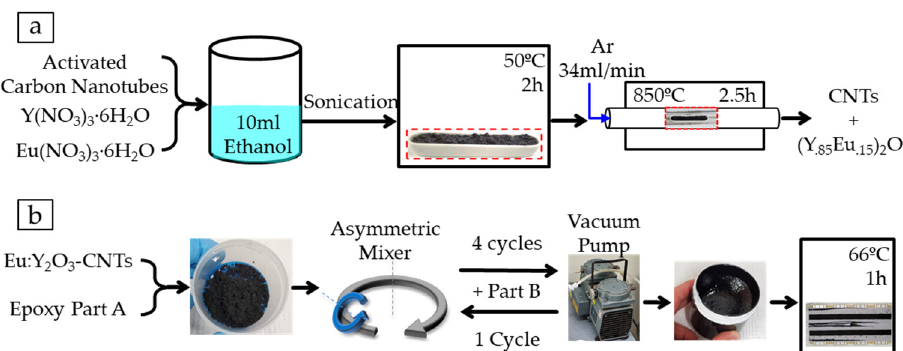
Figure 1. Depiction of the processes for: ( a ) introducing Eu:Y 2 O 3 nanoparticles to CNT walls; ( b ) fabrication of composite electrical boards and samples from epoxy and CNT pulp.